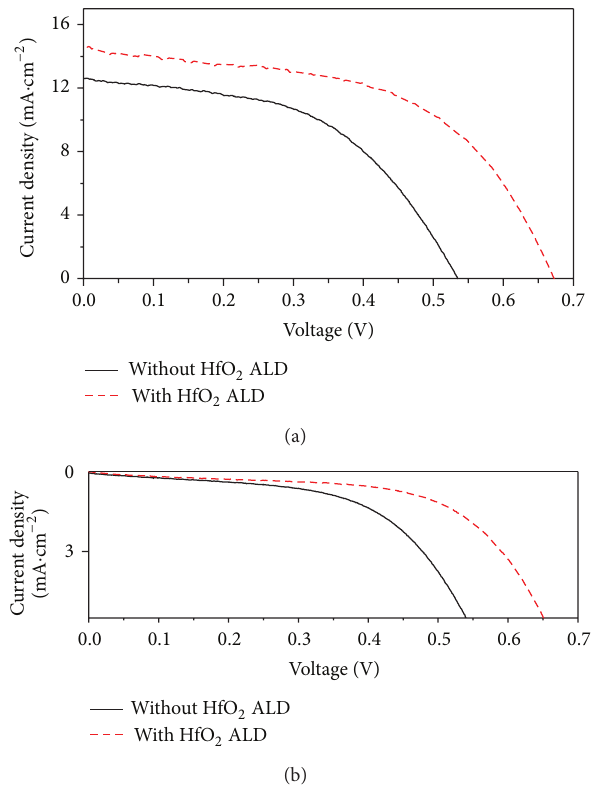
a Average values and standard deviations are based on 3-4 devices. Table 2: Photovoltaic properties of devices before and after the insertion of a compact HfO